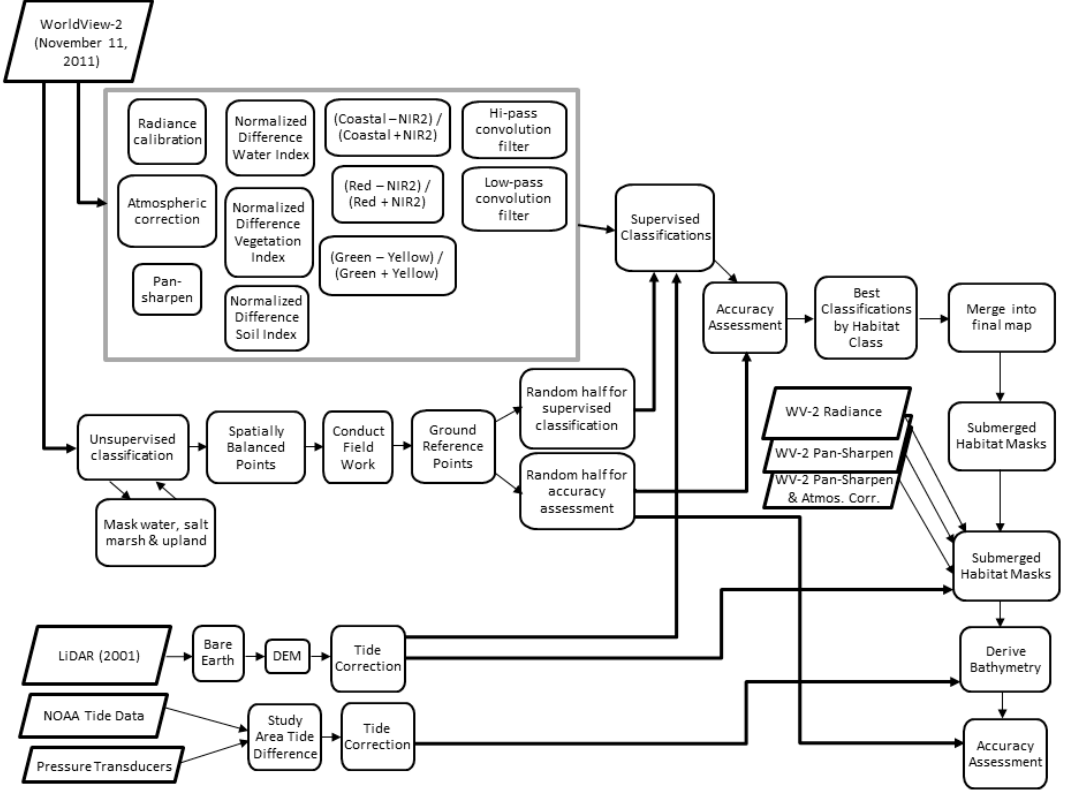
Figure 2. Project methods consist of multiple image processing techniques to test the accuracy of WorldView-2 for mapping emergent and submerged coastal habitats, extensive fieldwork for training the image processing and accuracy assessment, and incorporating LiDAR data for both image processing and testing the ability of WV-2 to map bathymetry.